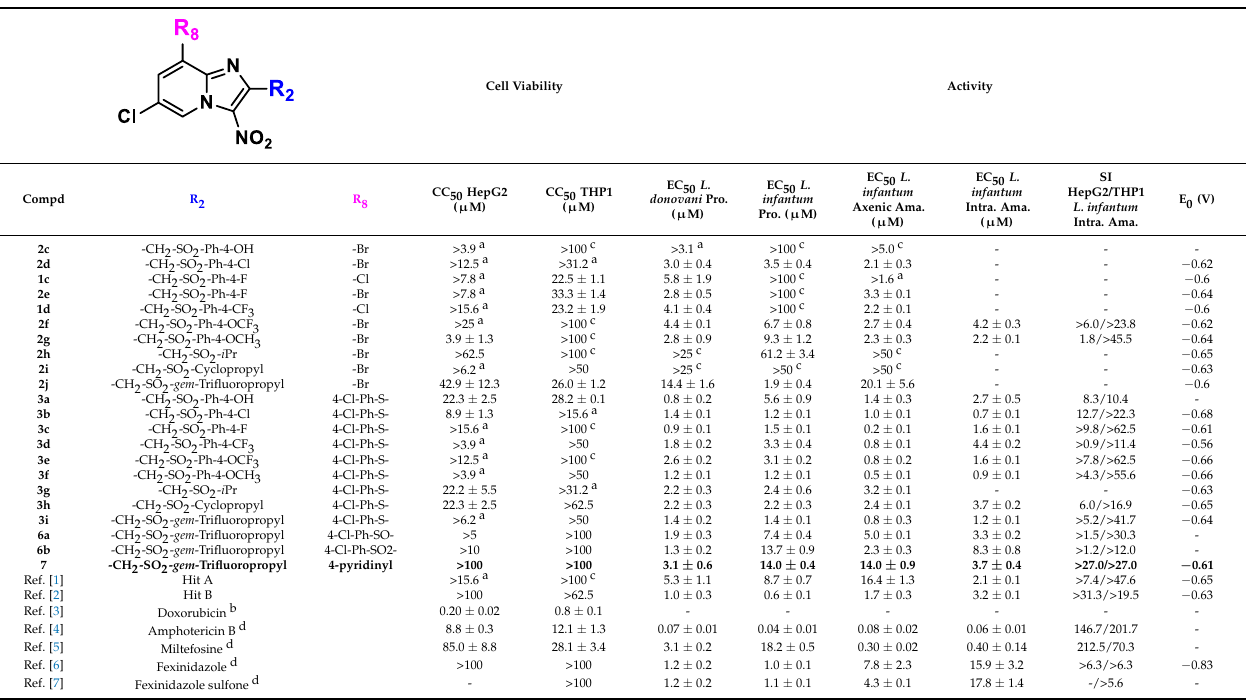
Table 2. In vitro evaluation of molecules 1c - 7 on L. donovani promastigotes, L. infantum promastigotes, L. infantum axenic amastigotes, L. infantum intracellular amastigotes, the human hepatocyte HepG2 and human leukemia monocytic THP1 cell lines. Redox potentials (E 0 ) of the nitro group were measured using cyclic voltammetry and corrected versus Normal Hydrogen Electrode (NHE). Weighted clogP were computed by the SwissADME online tool.